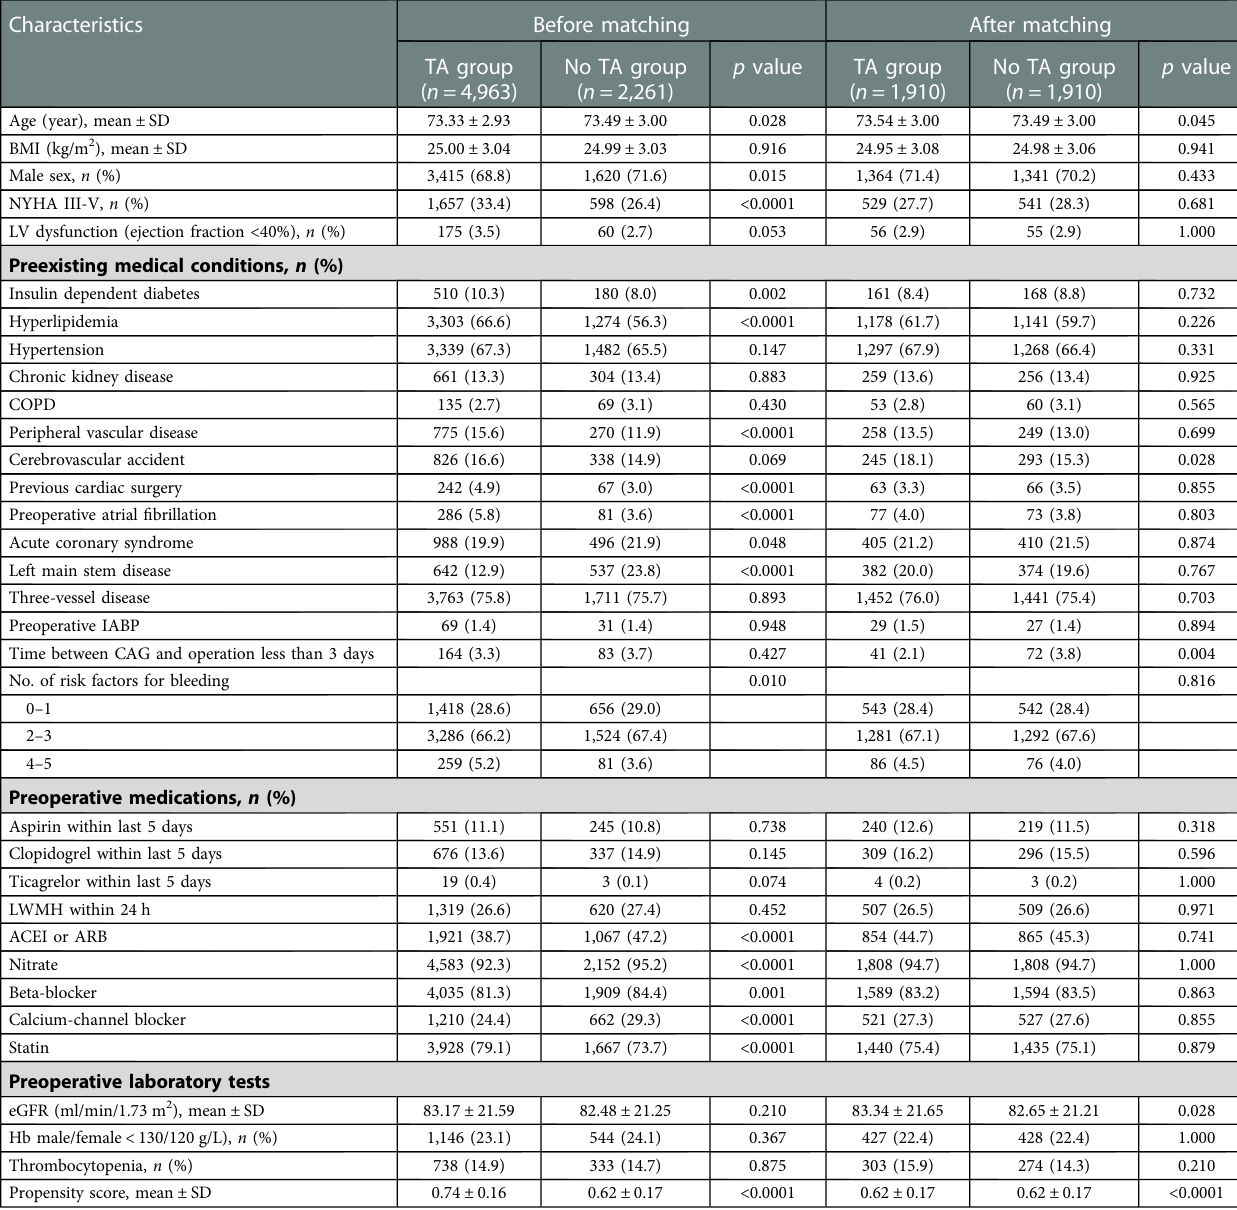
TABLE 1 The baseline information of elderly patients undergoing CABG with or without TA administration.